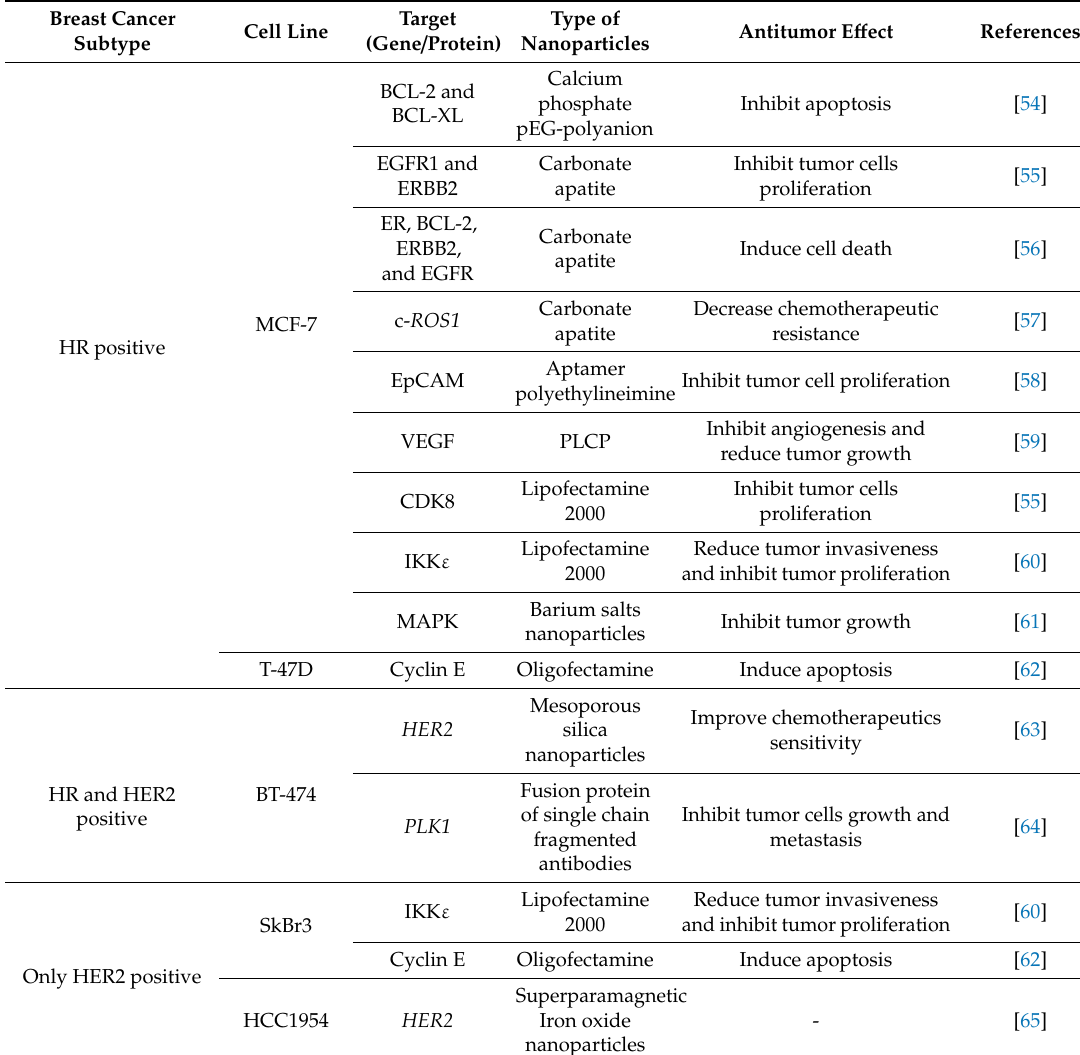
Table 1. E ff ectiveness of siRNA-loaded nanotherapeutics in patients with HR and / or HER2 positive breast